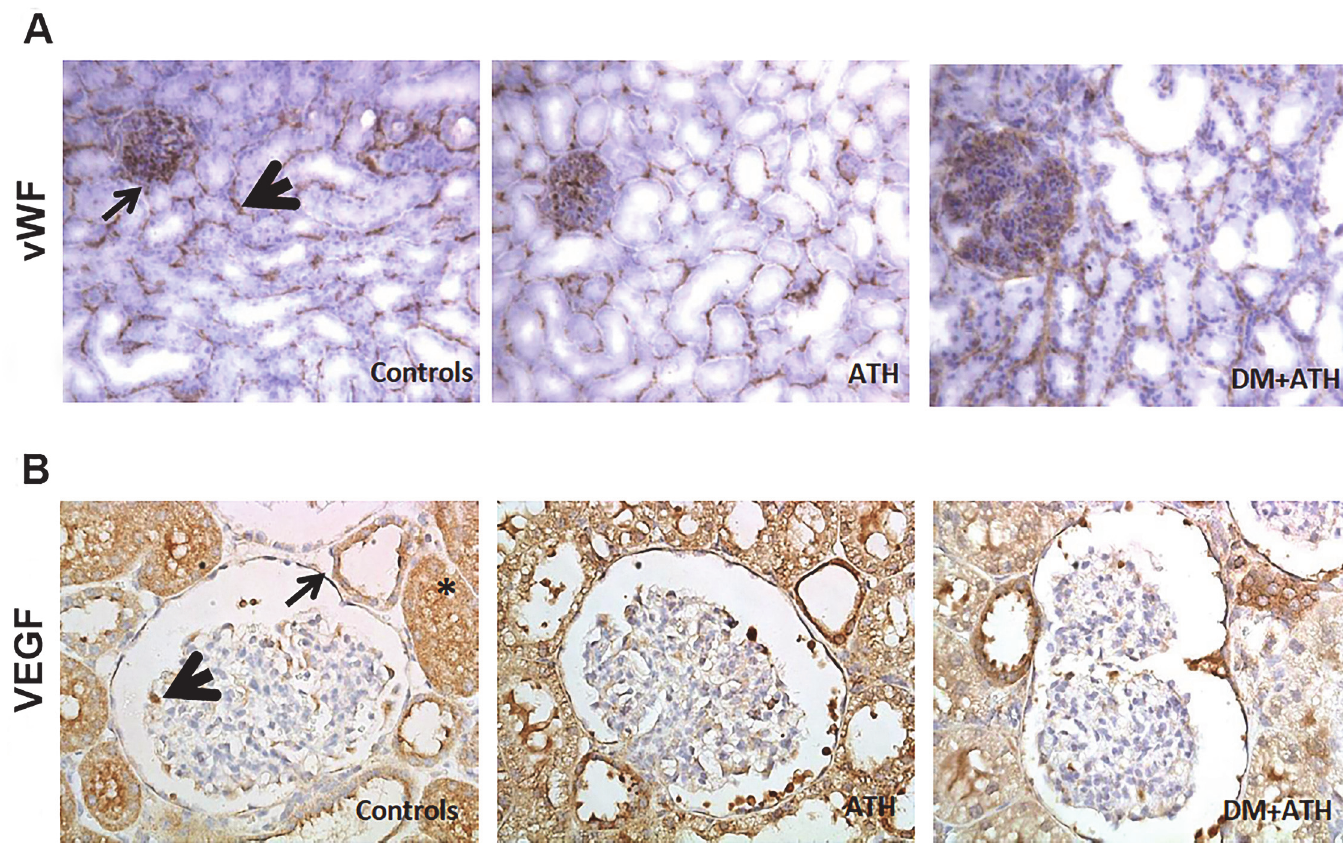
Fig 4. No difference in renal vWf and VEGF-A expression. A. Representative illustrations of kidney sections stained with endothelial marker vWF (arrow: glomerulus; arrowhead: peritubular area) in Controls, ATH, and DM+ATH pigs. B. Representative images of kidney sections stained with VEGF in Controls, ATH, and DM+ATH pigs showing expression in podocytes (arrow head), parietal epithelial cells (thin arrow) and tubuli (asterix). Original magnification of A: x 200 and B: